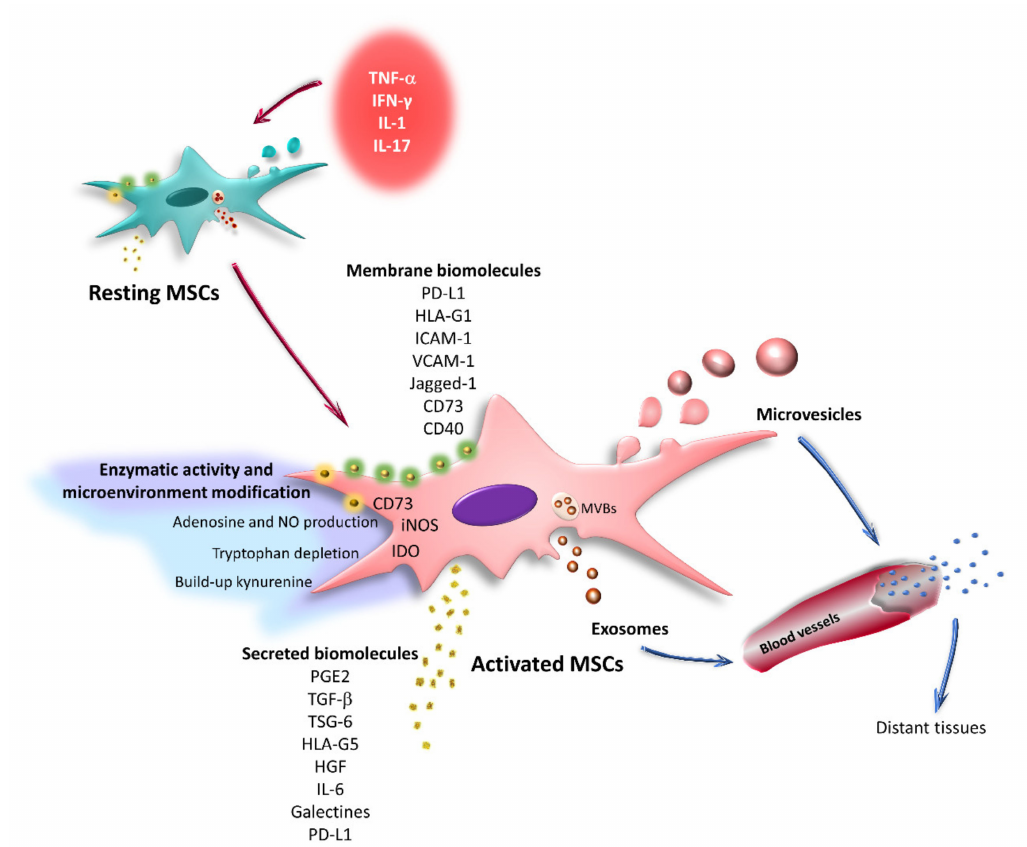
Figure 1. Immunoregulatory mechanisms of activated MSCs. MSCs are generally in a resting state with low or no expression of the molecules involved in their immunoregulatory function. However, when exposed to proinflammatory cytokines such as TNF- α , IFN- γ , IL-1, and IL-17, these cells become activated. This event increases or induces the expression of immunoregulatory molecules in MSCs, which can be secreted or remain attached to the cell membrane. In addition, resting and activated MSCs release extracellular vesicles (exosomes and microvesicles), which are capable of traveling through body fluids and reaching distant sites, where they establish contact with immune